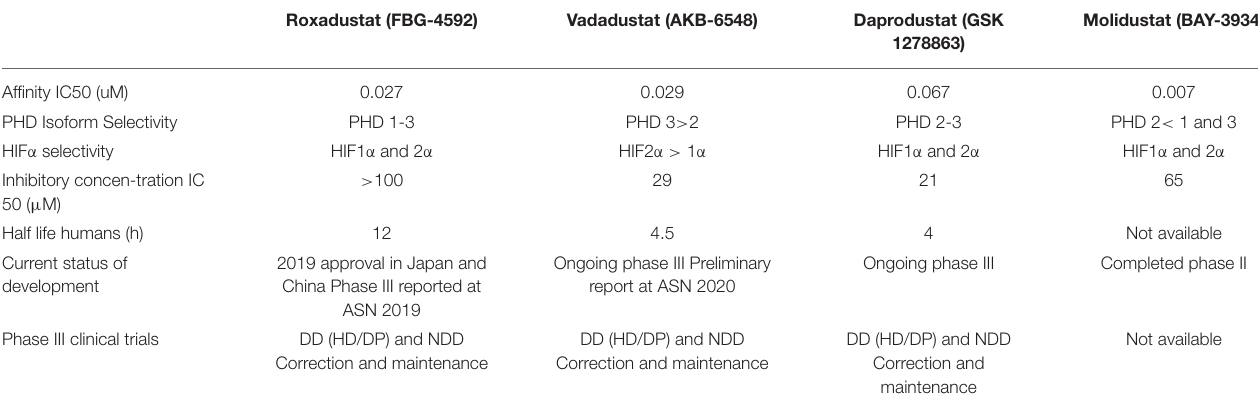
TABLE 2 | Pharmacological characteristics and current knowledge status of different Hypoxia-inducible factor prolyl hydroxylase